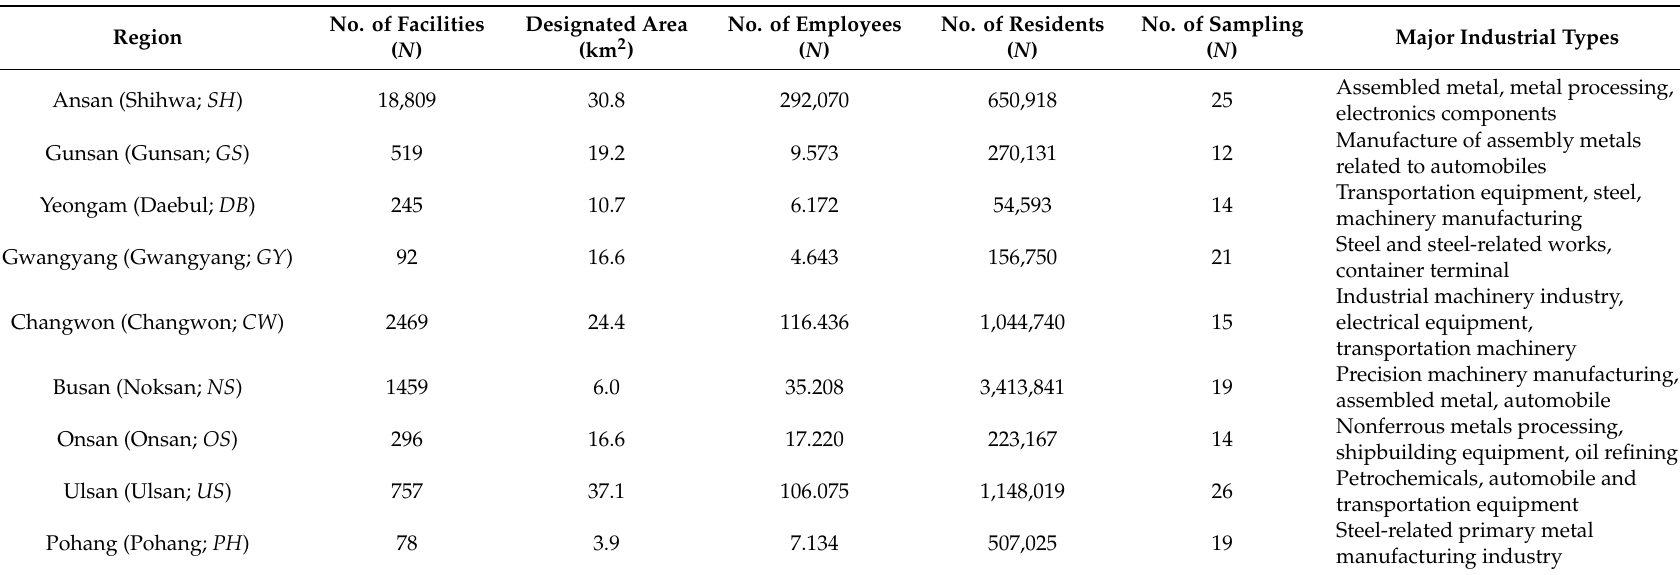
Table 1. Information on the number of operating facilities, designated area (km 2 ), the number of employees, residents and major industrial types in di ff erent industrial regions collected from the road dust (RD) of this